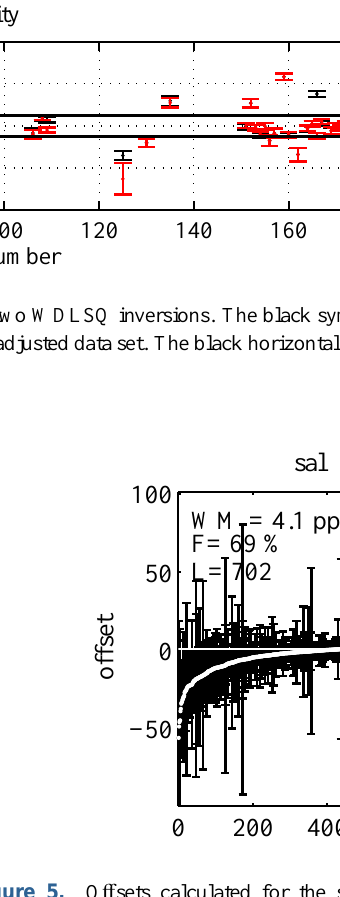
Figure 5. O ff sets calculated for the salinity crossovers in the CARINA-ATL data after adjustments have been applied. WM: the weighted mean of the o ff sets (see text); F : the percentage of o ff sets indistinguishable from 0 within their uncertainty; L : the number of